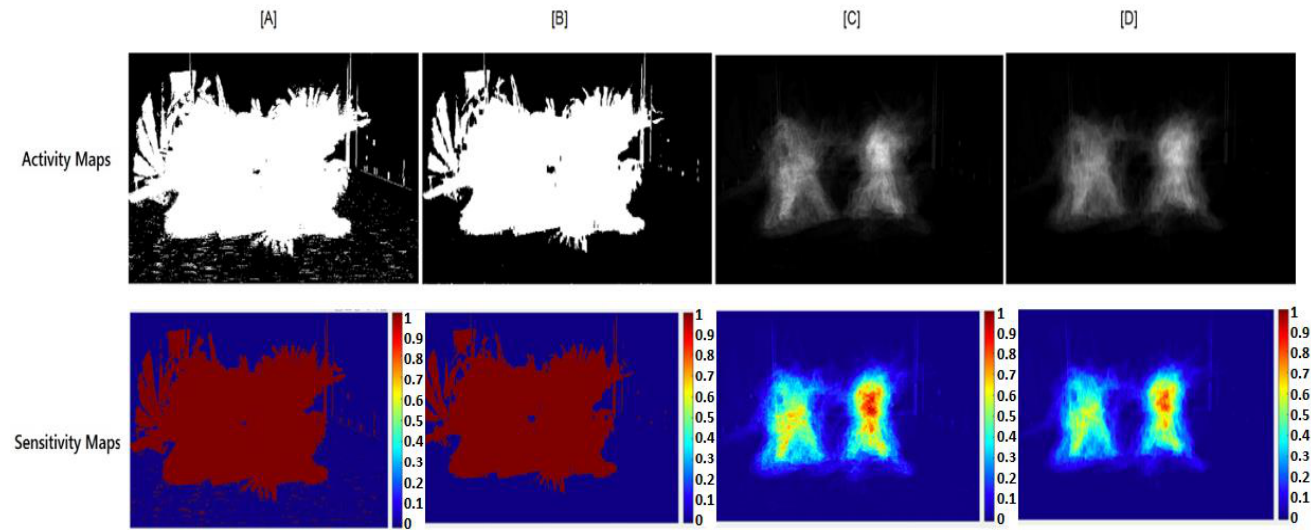
Figure 12. Simulation results from video dataset 5 by the proposed framework (( a ) extracted frames in grayscale, ( b ) foreground by adaptive background subtraction post-binarization and ( c ) optical flow).